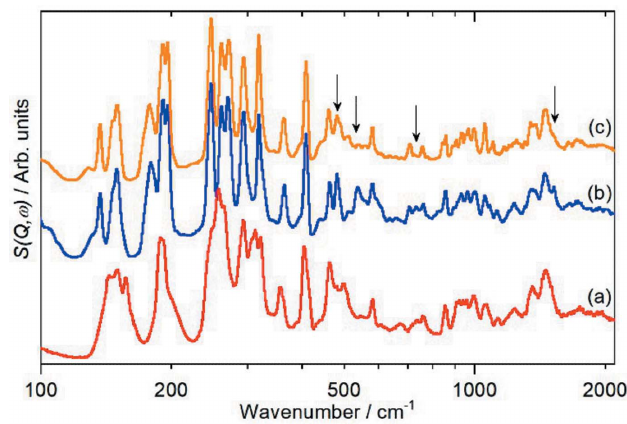
Figure 6 INS spectra at 10 K of ( a ) TMP, ( b ) TMP–H 2 O and ( c ) TMP–D 2 O. The arrows indicate positions where there is a difference between the H 2 O and D 2 O complexes. Note that the x axis is on a log 10